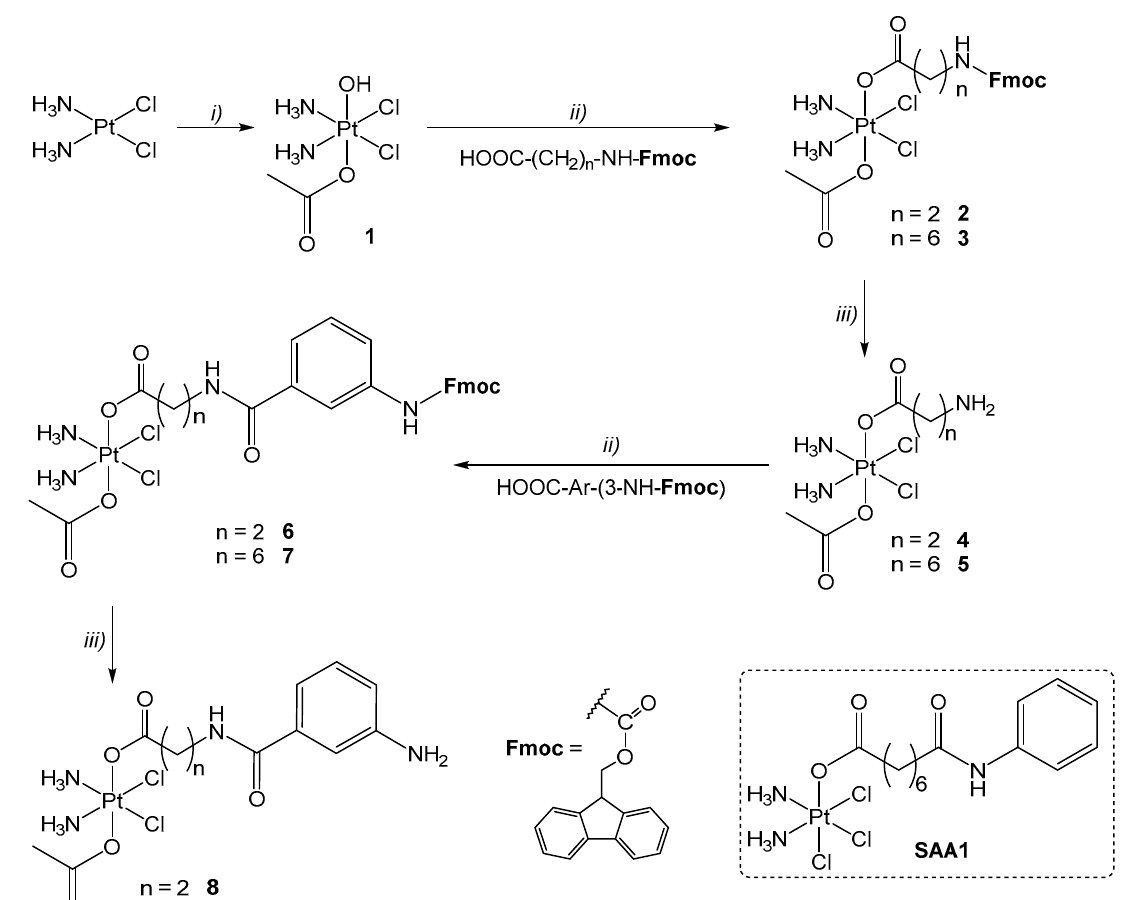
Figure 2. Scheme of the reaction pathways for the synthesis of the compound under investigation. (i) H 2 O 2 , acetic acid; (ii) HATU, DIPEA, DMF; (iii) piperidine, DMF. DIPEA = N , N -diisopropylethylamine; DMF = N , N -dimethylformamide; HATU = 1-[bis(dimethylamino)methylene]-1 H -1,2,3-triazolo[4,5-b]pyridinium 3-oxide hexafluorophosphate.